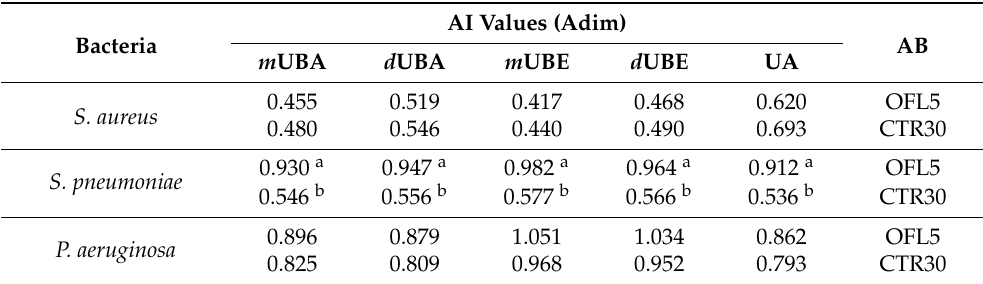
Table 6. Antibacterial activity index of U. barbata extracts and UA compared to both standard antibiotic